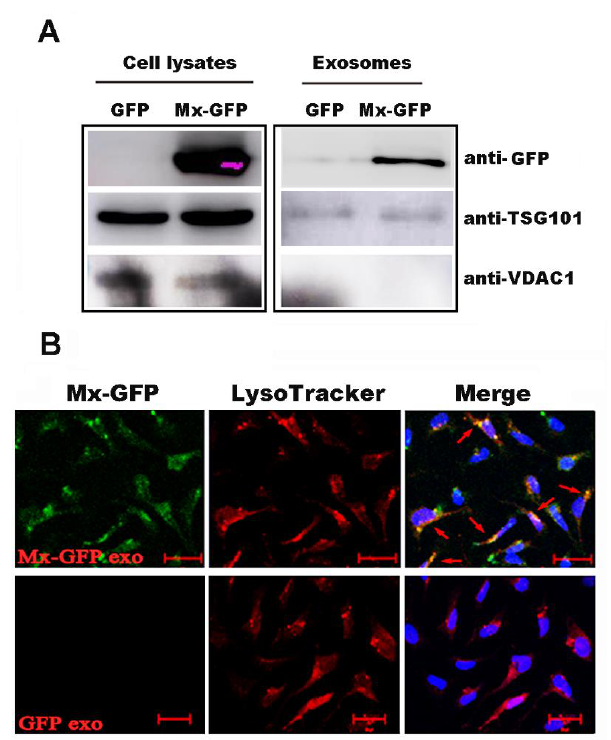
Figure 4. Mx1 protein transferred to the recipient cells though the exosomes. ( A ) Cells were transfected with Mx1-GFP-expressing vectors secreted exosomes with Mx1. Exosomes were isolated from cell cultures from transiently transfected MFF-1 cells. Cellular and exosomal lysates were analyzed by Western blot for the presence of Mx1, TSG101, and voltage-dependent anion channel protein 1 (VDAC1, a mitochondrial marker). ( B ) Confocal microscopy showed the Mx1-GFP exosomes were internalized by MFF-1 cells. The cells were transfected with an Mx1-GFP-expressing vector, and the exosomes were isolated from culture supernatant. Exosomes were incubated with MFF-1 cells for 2 h and then with LysoTracker (LT) for 1